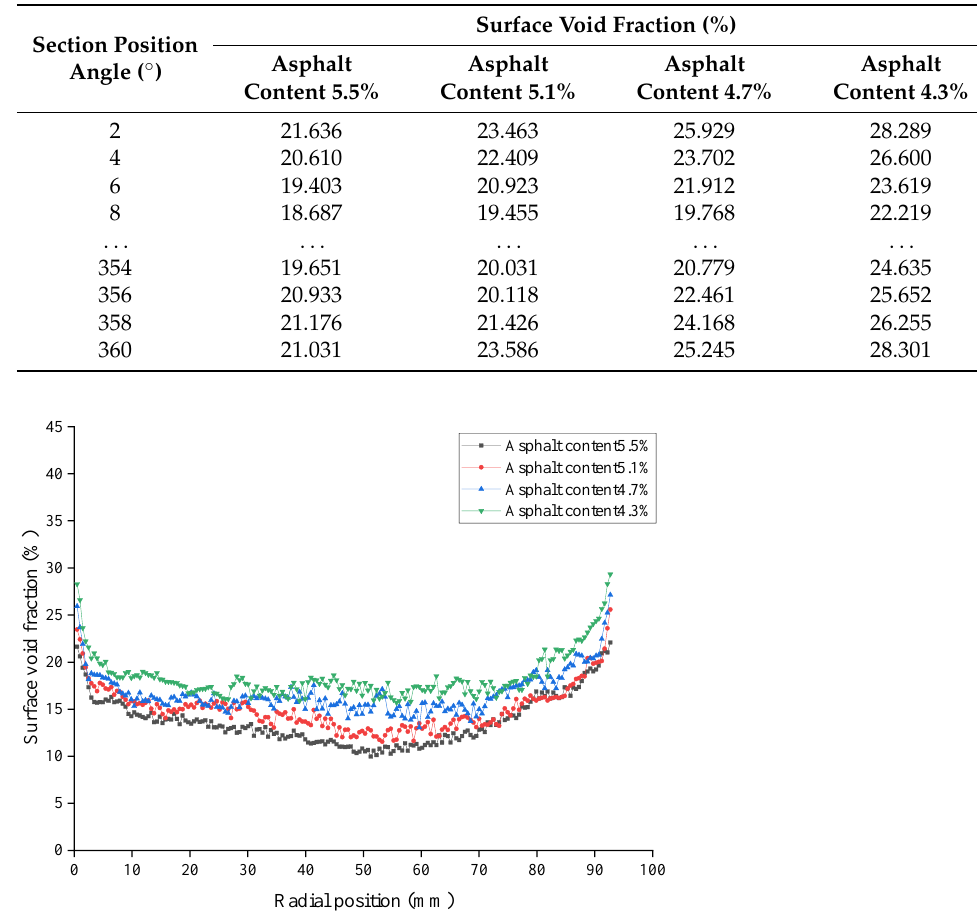
Table 7. Characteristic parameters of bulk voids in EPA-13 with 5.5% asphalt content.